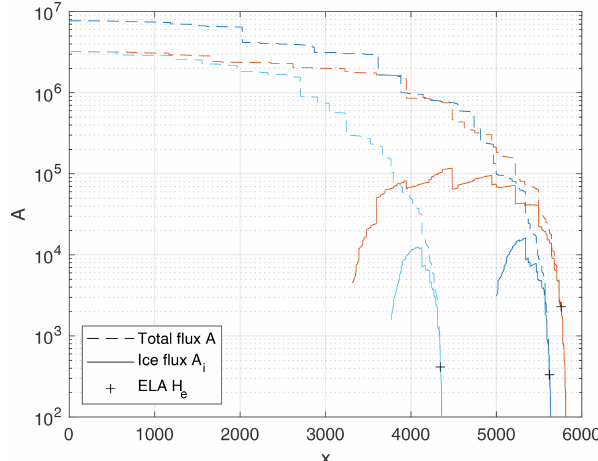
Figure 8. Longitudinal profiles of the largest flow paths in the flu- vioglacial topographies shown in Fig. 7 (solid lines) and Fig. 9 (dashed lines). The lower set of lines refers to the original along- stream coordinate x , while the upper set of lines depicts the χ - transformed profiles. Both start from the boundary of the